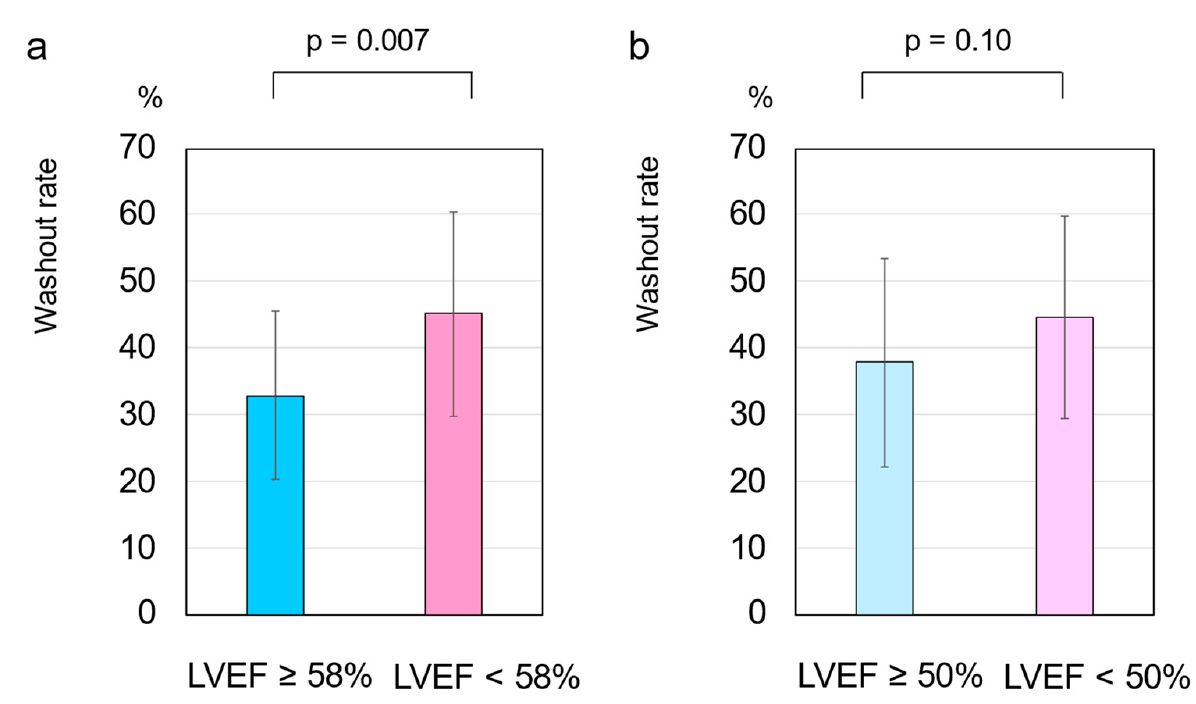
Figure 2. ( a ) The washout rate (WR) was significantly lower in patients with a left ventricular ejection fraction (LVEF) of <58% compared to that of those with an LVEF of ≥ 58% (32.9 ± 12.6% vs. 45.1 ± 15.4%, p = 0.007). ( b ) No significant differences were found in the WR between patients with an LVEF of ≥ 50% and those with an LVEF of <50% (37.8 ± 15.7% vs. 44.6 ± 15.2%, p = 0.10). These data were compared using an unpaired Student’s t -test.